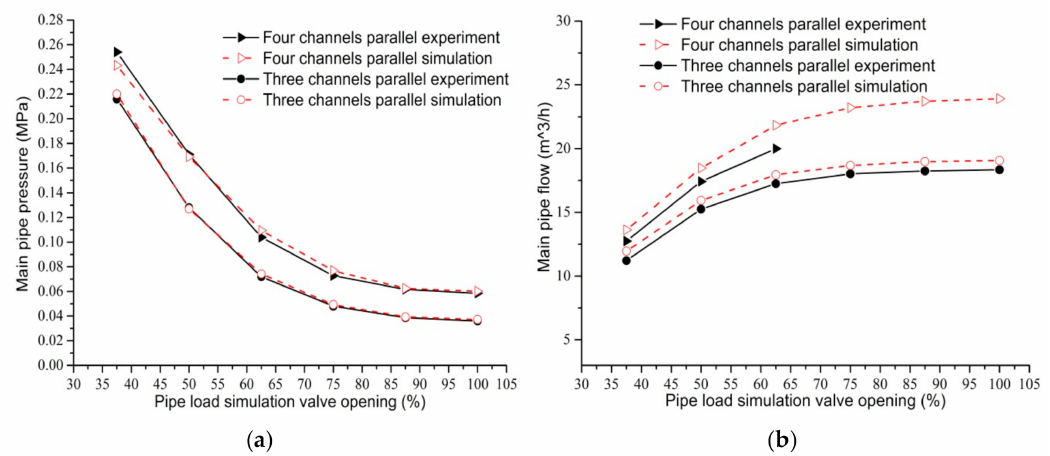
Figure 6. Constant flow performance verification: ( a ) Main pipe pressure under di ff erent pipe loads; ( b ) Main pipe flow under di ff erent pipe